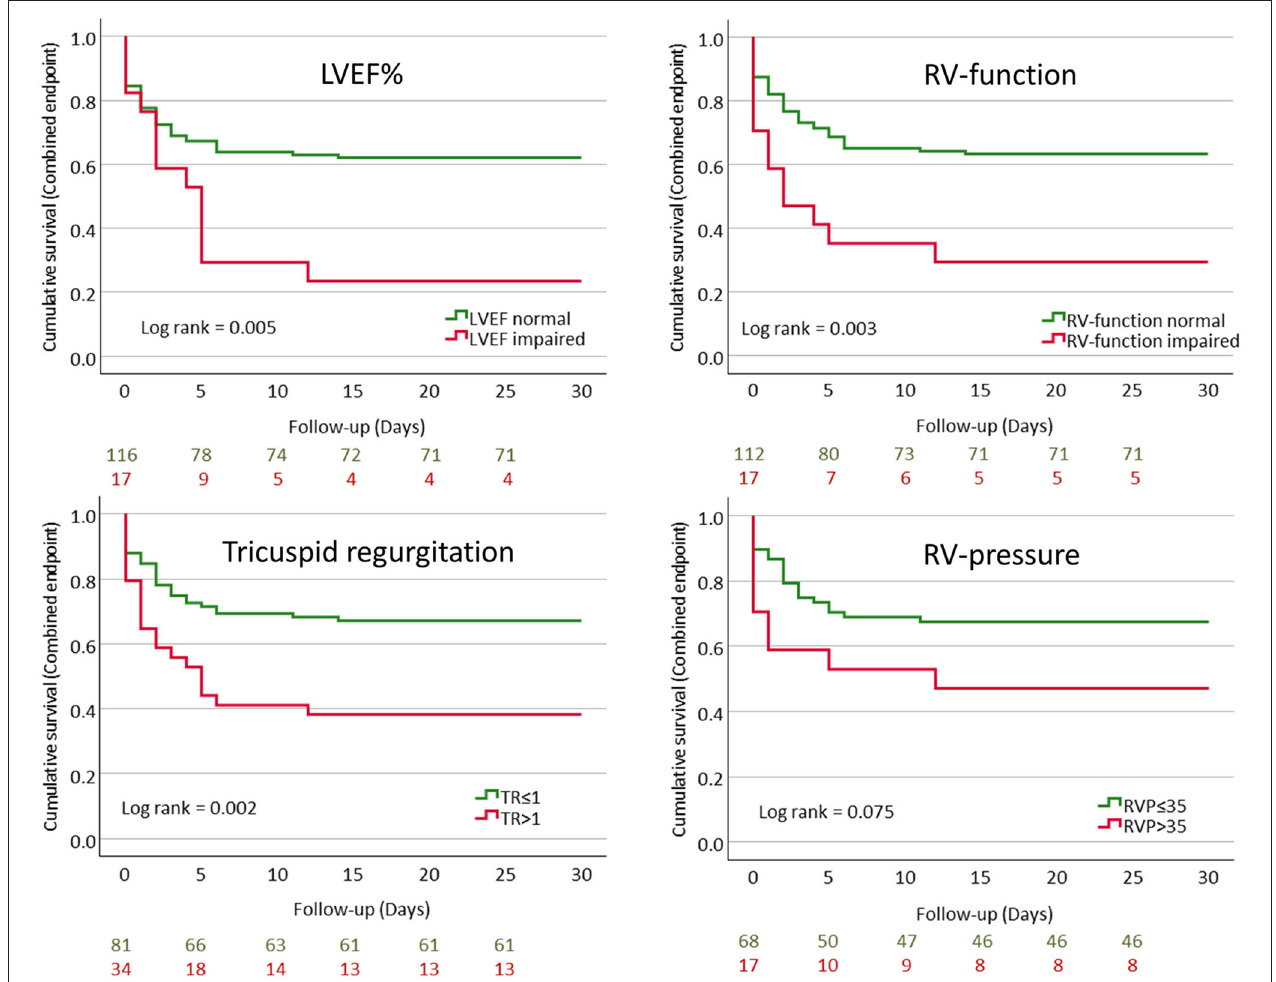
FIGURE 1 | Kaplan–Meier curves showing cumulative event-free survival for the combined endpoint (mechanical ventilation and/or mortality) stratified according to LVEF%, RV-function, tricuspid regurgitation, and RV-pressure.